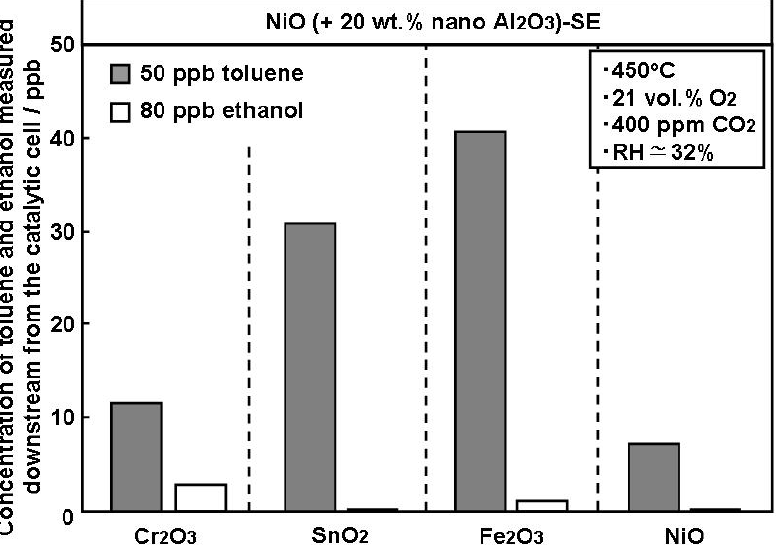
Figure 4. Catalytic activity comparison of different oxides for the oxidation of toluene and ethanol, evaluated with a YSZ-based sensor utilizing NiO(+Al temperature of 450 °C under humid conditions (RH ⋍